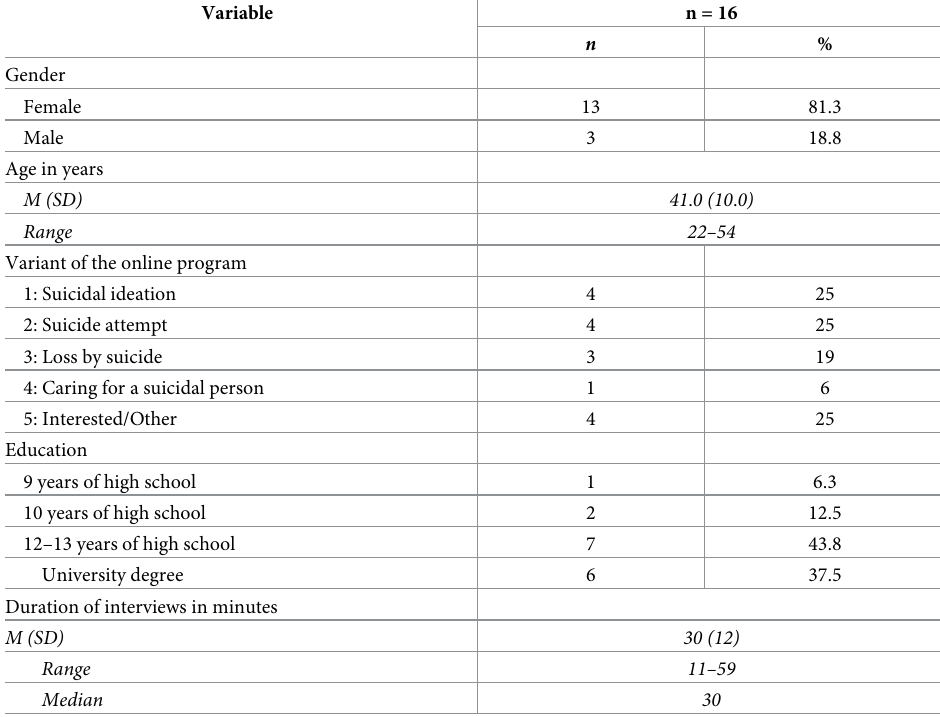
Table 3. Demographic data of participants, program variant, and duration of follow-up telephone